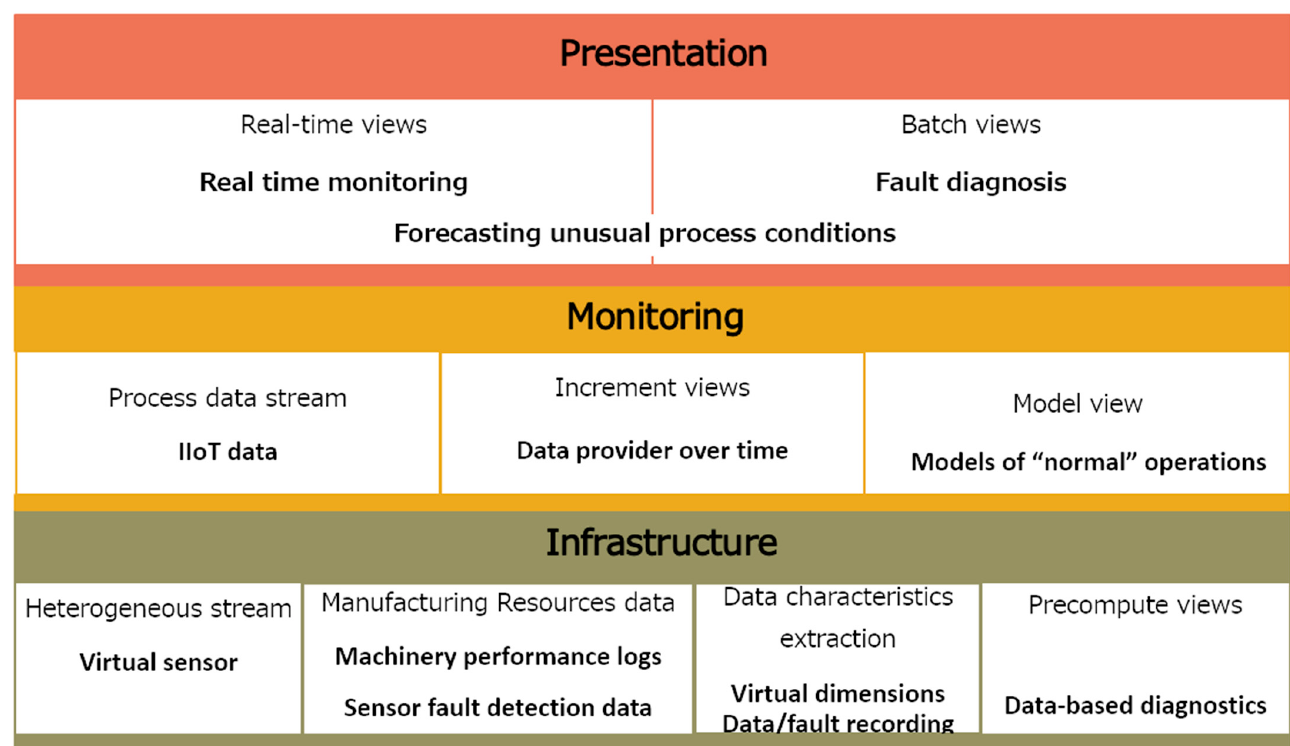
Figure 10. Architectural instance for industrial-analytics Big Data for the use case of fault diagnosis.